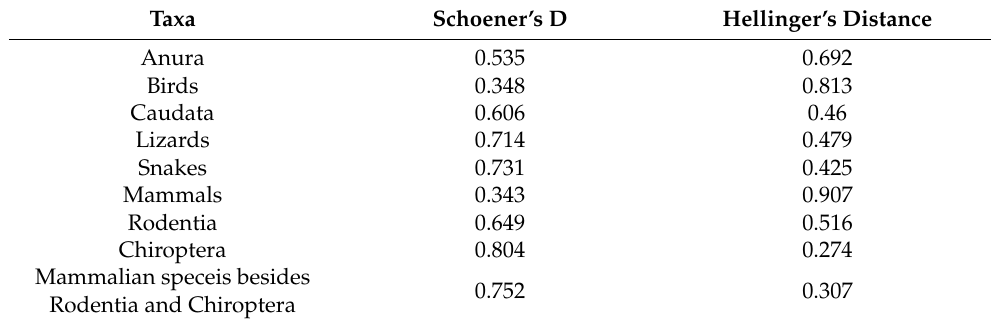
Table 1. Schoener’s D and Hellinger’s distance between functional diversity and species